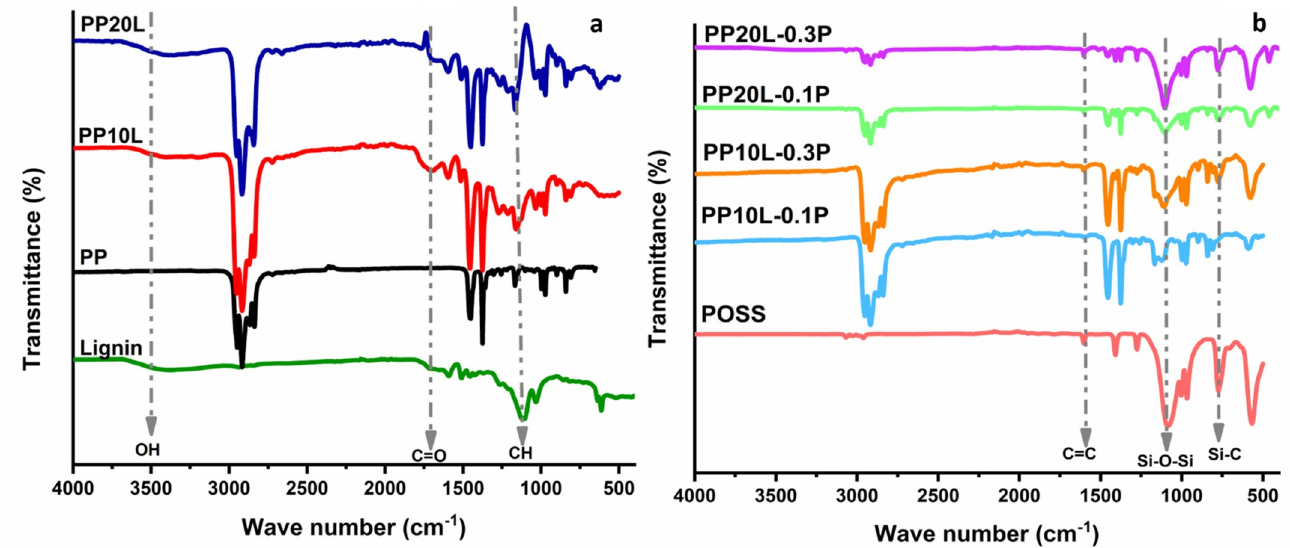
Figure 4. FTIR spectra of polypropylene, lignin, and polypropylene/lignin blend sponges ( a ) without POSS and ( b ) with POSS.